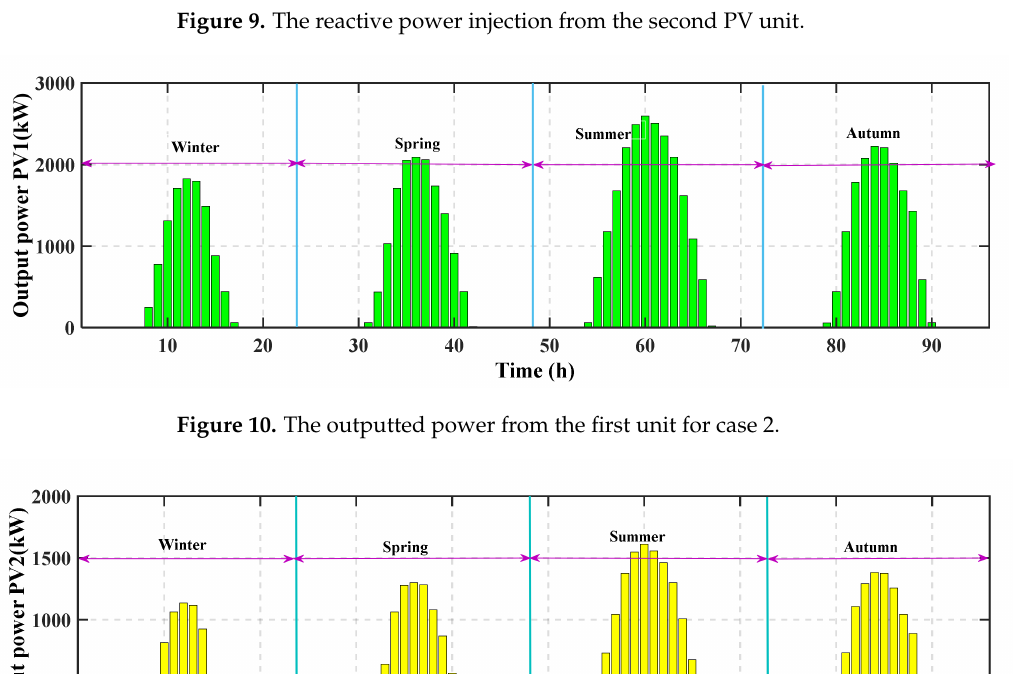
Figure 9. The reactive power injection from the second PV unit.